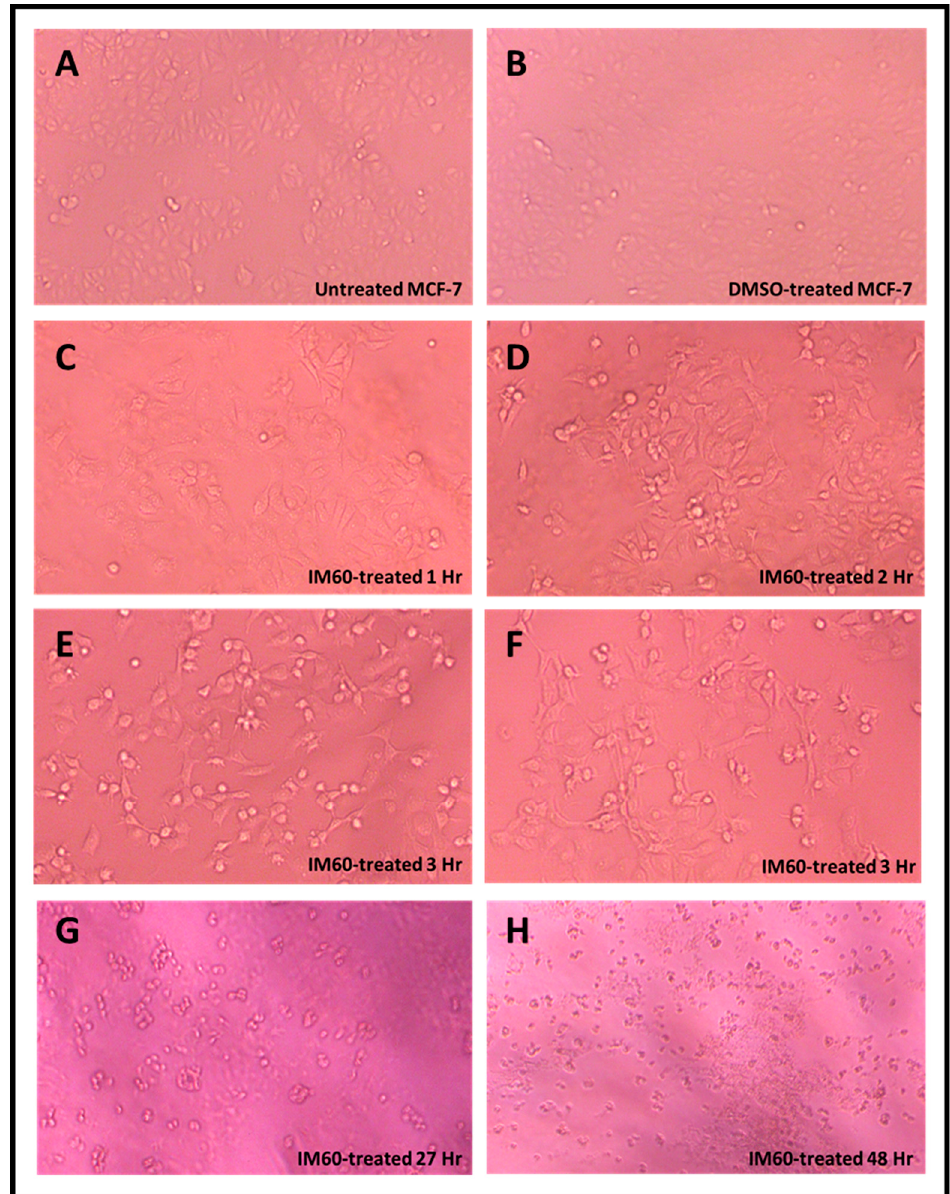
Figure 7. Photomicrographs of MCF-7 cells treated with IM60 compound at 0.425 mM along with its DMSO control for various time points post treatment (magnification 400×). Panels A – F are from one experiment, while Panels G and H are from another experiment that was conducted for a longer time period.